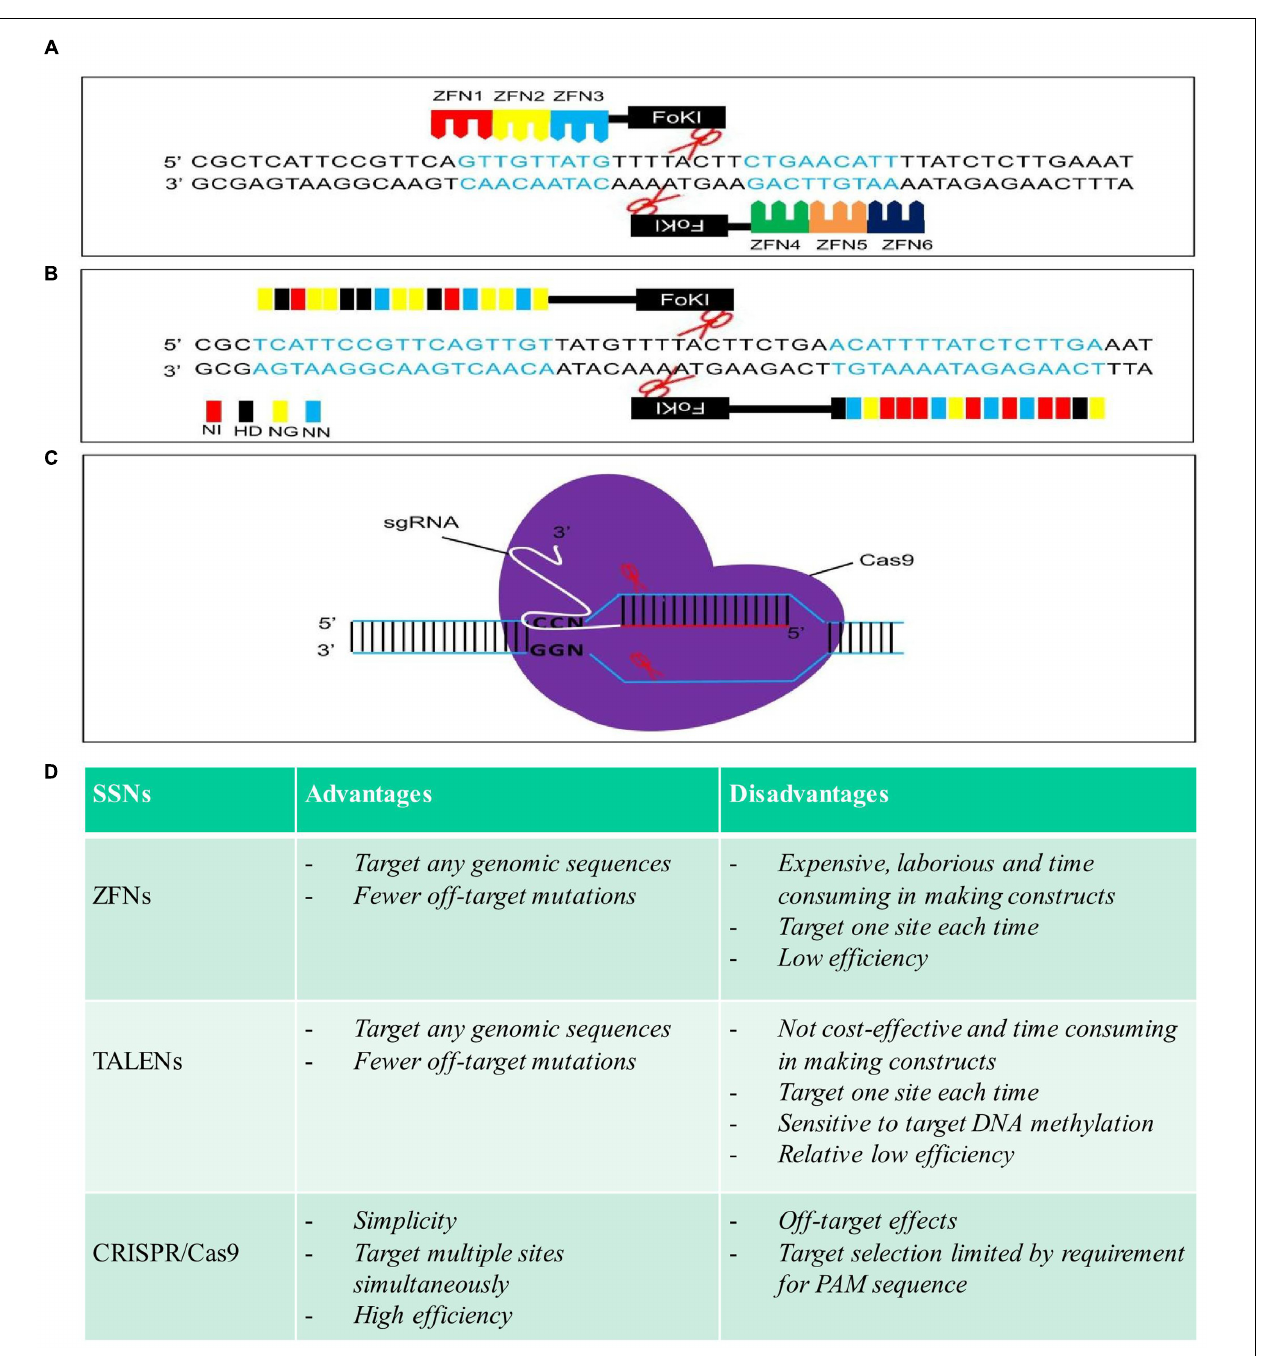
FIGURE 1 | Schematic structures, advantages, and disadvantages of zinc finger nucleases (ZFNs), transcription activator-like effector nucleases (TALENs), and clustered regularly interspaced short palindromic repeat (CRISPR)/Cas9. (A) , (B) , and (C) are schematic structures of ZFNs, TALENs, and CRISPR/Cas9 in the process of DNA cleavage, respectively. (D) Advantages and disadvantages of each sequence-specific nuclease